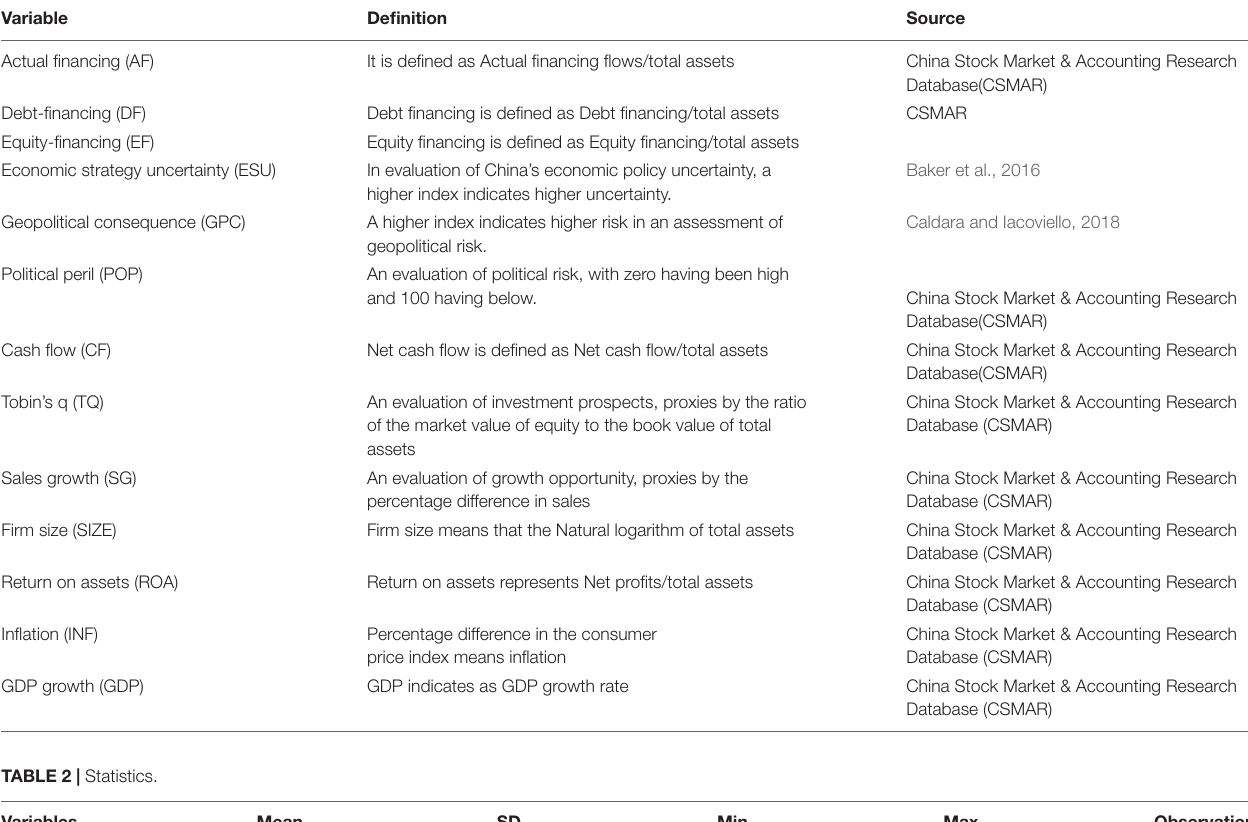
TABLE 1 | Variables’ list, definitions, and data resources.